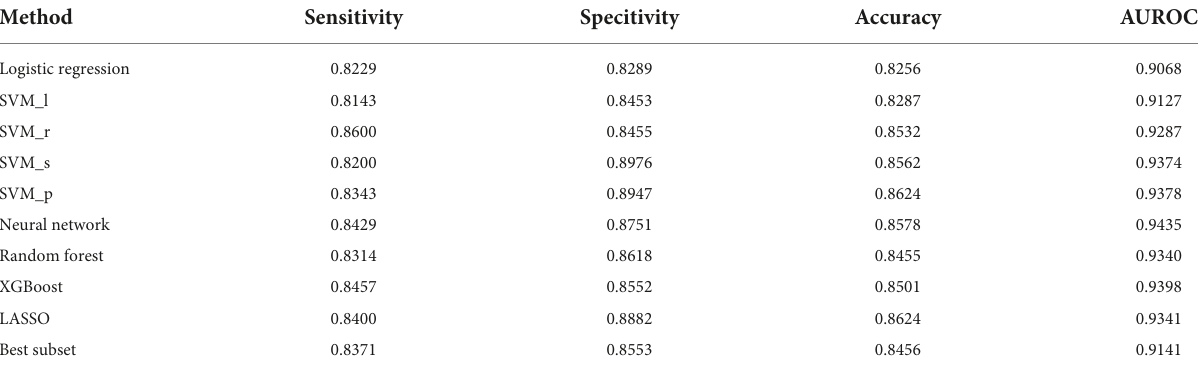
TABLE 2 Classification performance of each model evaluated internally by the double CV on the nursing